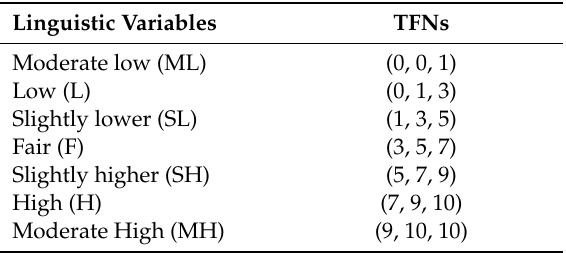
Table 2. Ratings of linguistic